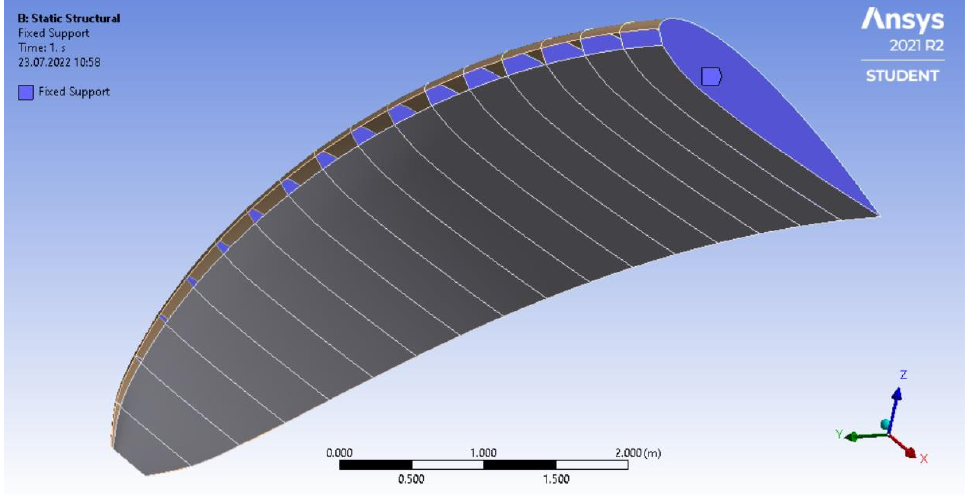
Figure 7. Attachment of the support for the numerical calculation.